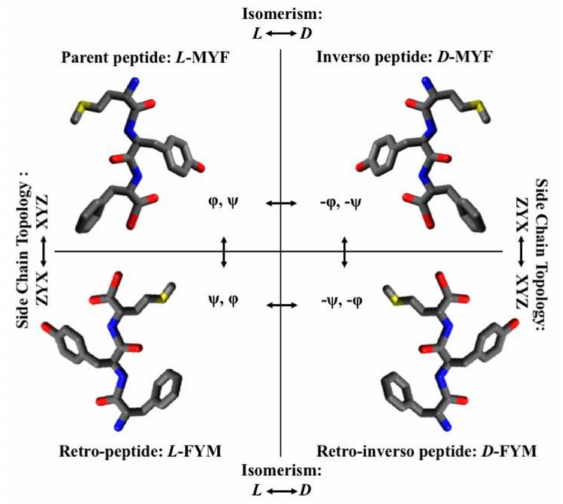
Figure 1. Topological relationship between a peptide and its inverso, retro, and retro-inverso ana- logues, illustrated for the example peptide MYF [17]. As shown, the topology of the side chains of the retro-inverso analogue, in the C-to-N orientation, is the same as the parent peptide in the N-to-C orientation (figure adapted by